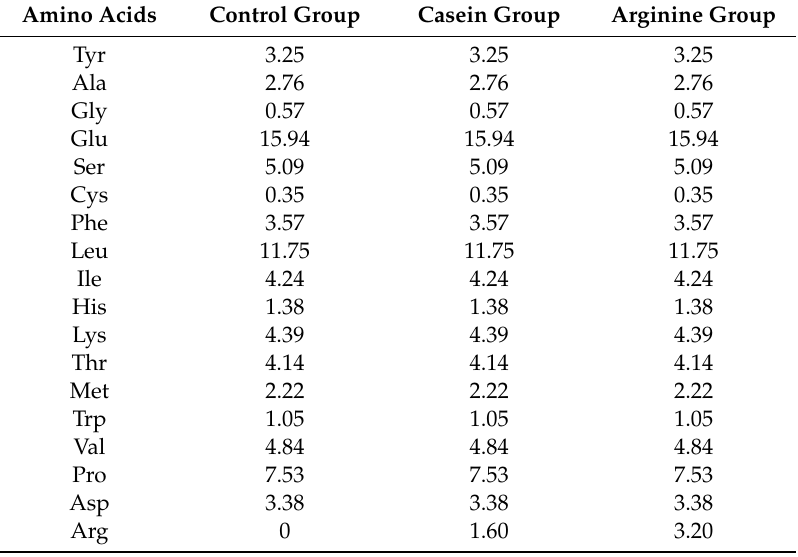
Table 1. Composition of amino acids in culture media of bovine mammary epithelial cells